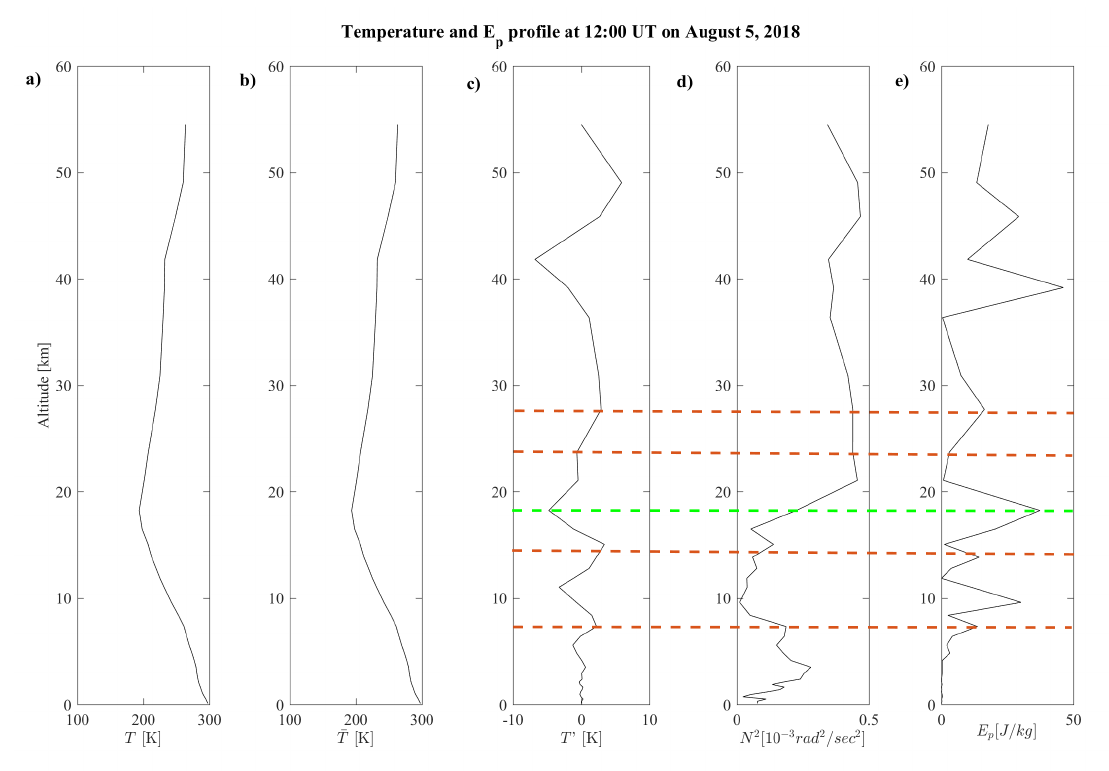
Figure 1. Co-seismic vertical profiles of: ( a ) temperature; ( b ) background temperature; ( c ) temperature deviation; ( d ) square term of Brunt − V ¨ ais ¨ al ¨ a frequency; ( e ) potential energy at 12:00 UT on 5 August 2018. Red horizontal dashed lines represent the AGW peaks identified; the green horizontal dashed line identify the tropopause